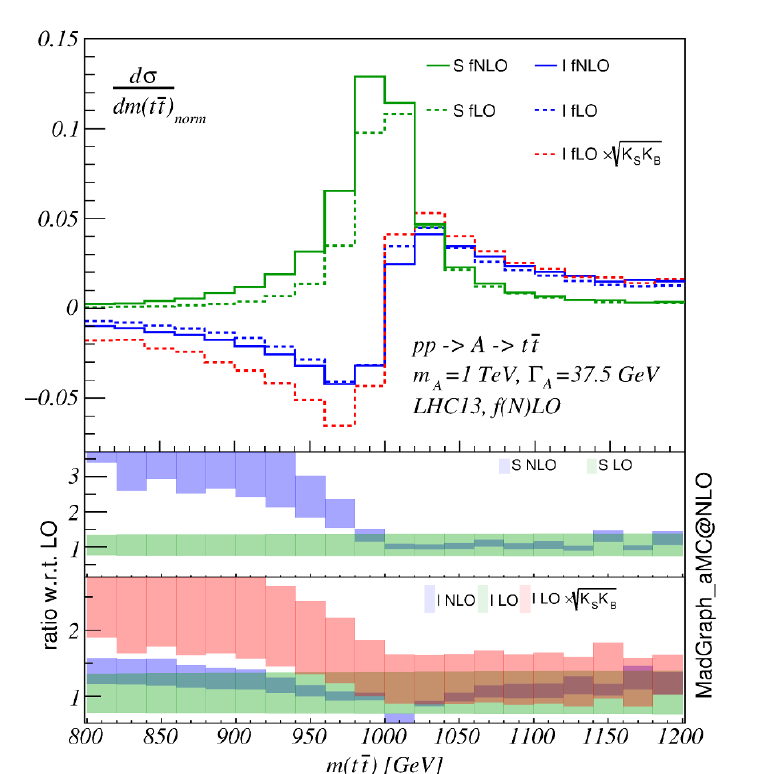
Figure 14 . Signal and interference lineshapes at (cid:12)xed order (N)LO for LHC 13 TeV. Results are normalised to the SM fNLO lineshape. Lower panels show the K-factors and the scale uncertainties of signal and interference